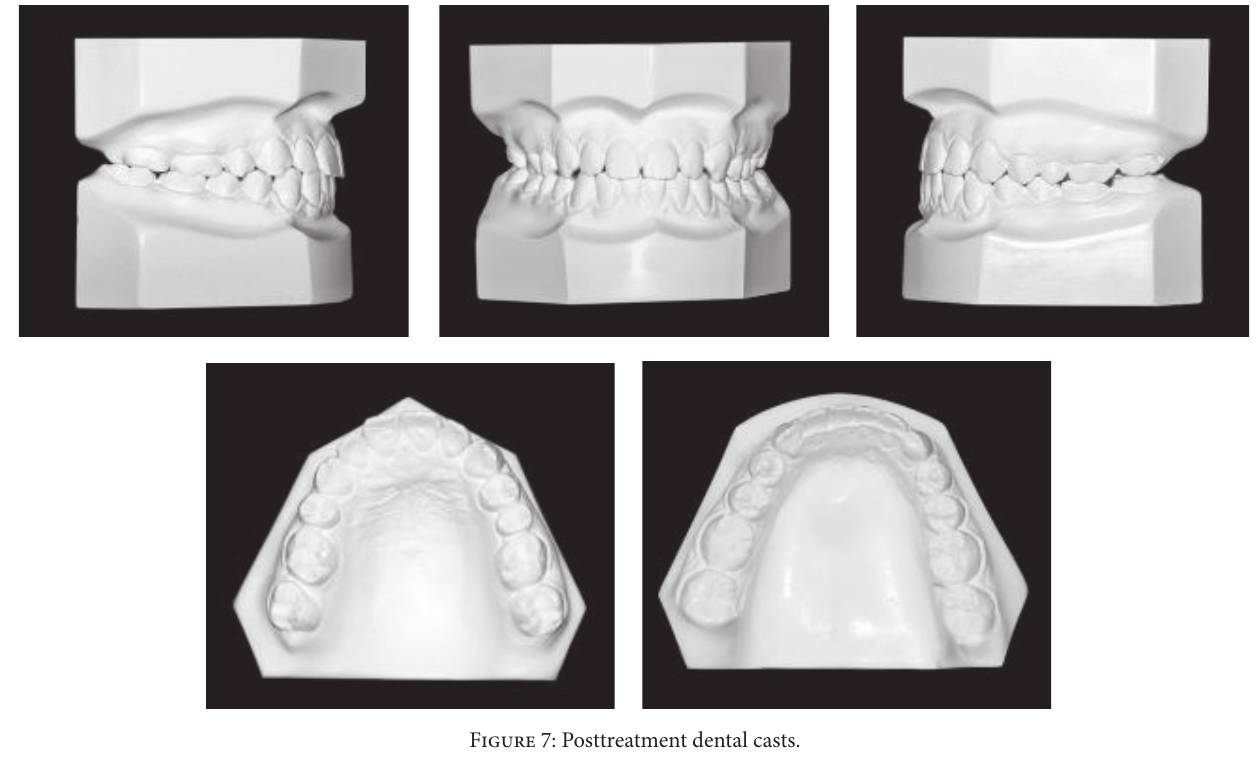
Figure 7: Posttreatment dental casts.